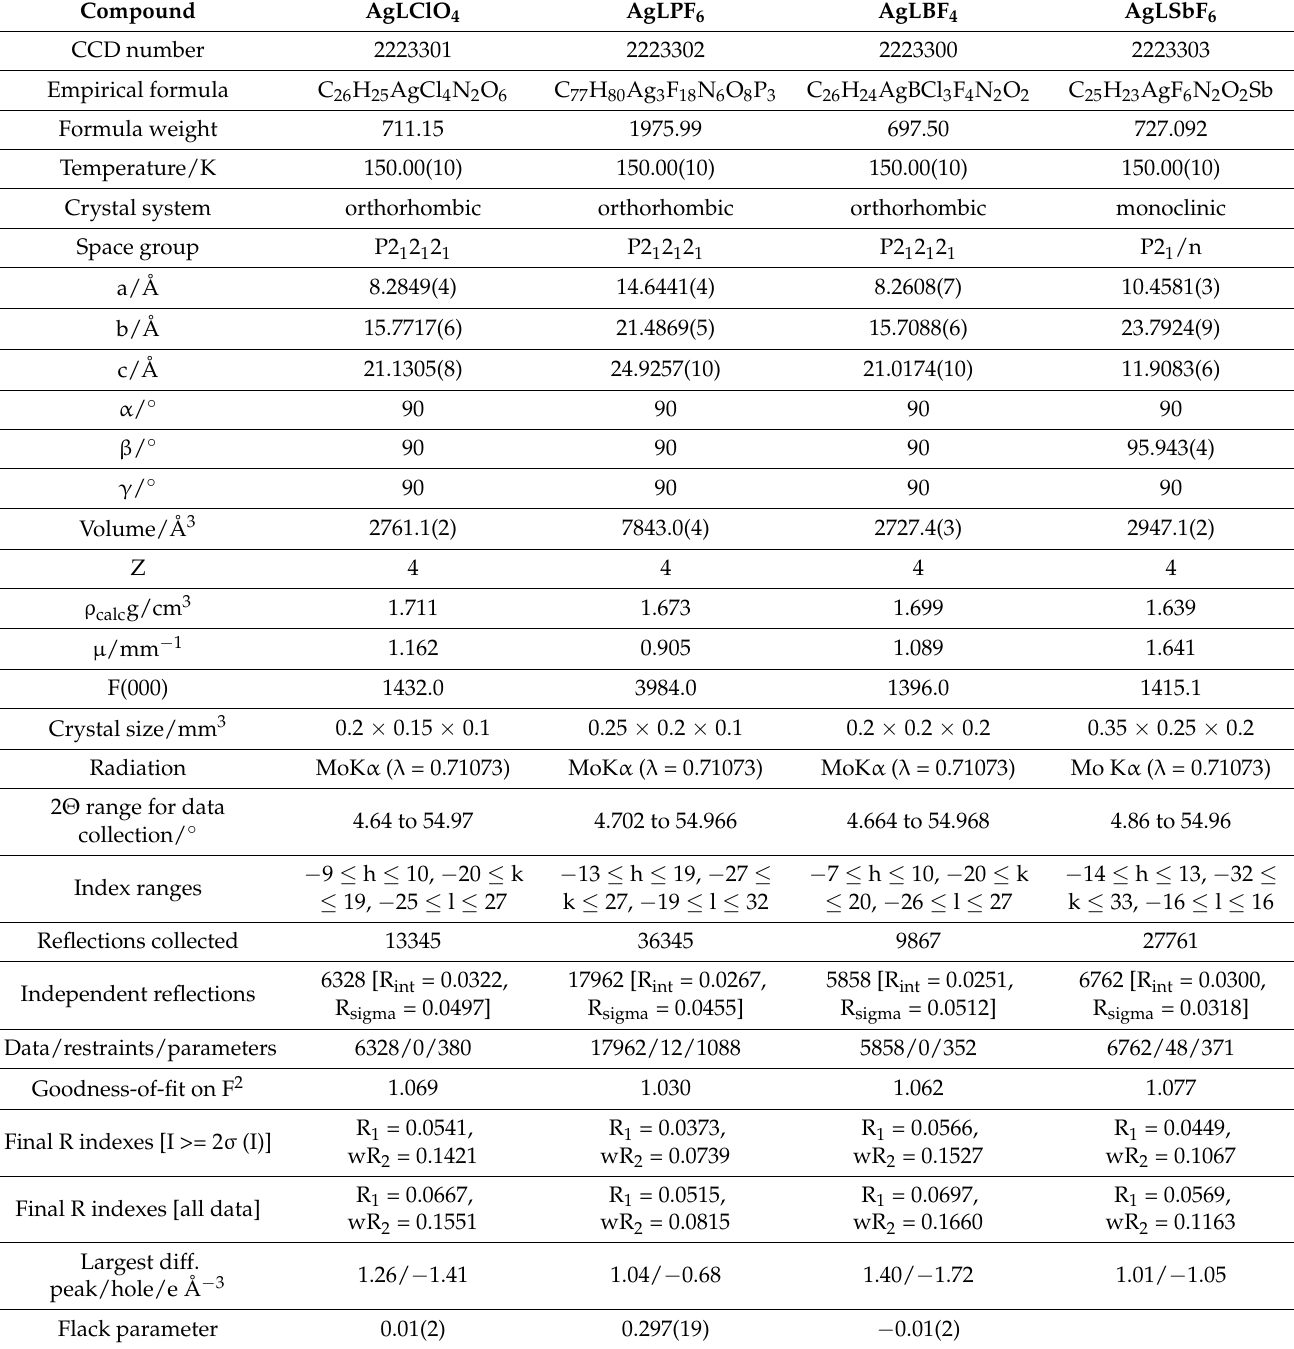
Table 1. Crystallographic data and structure refinement details for all